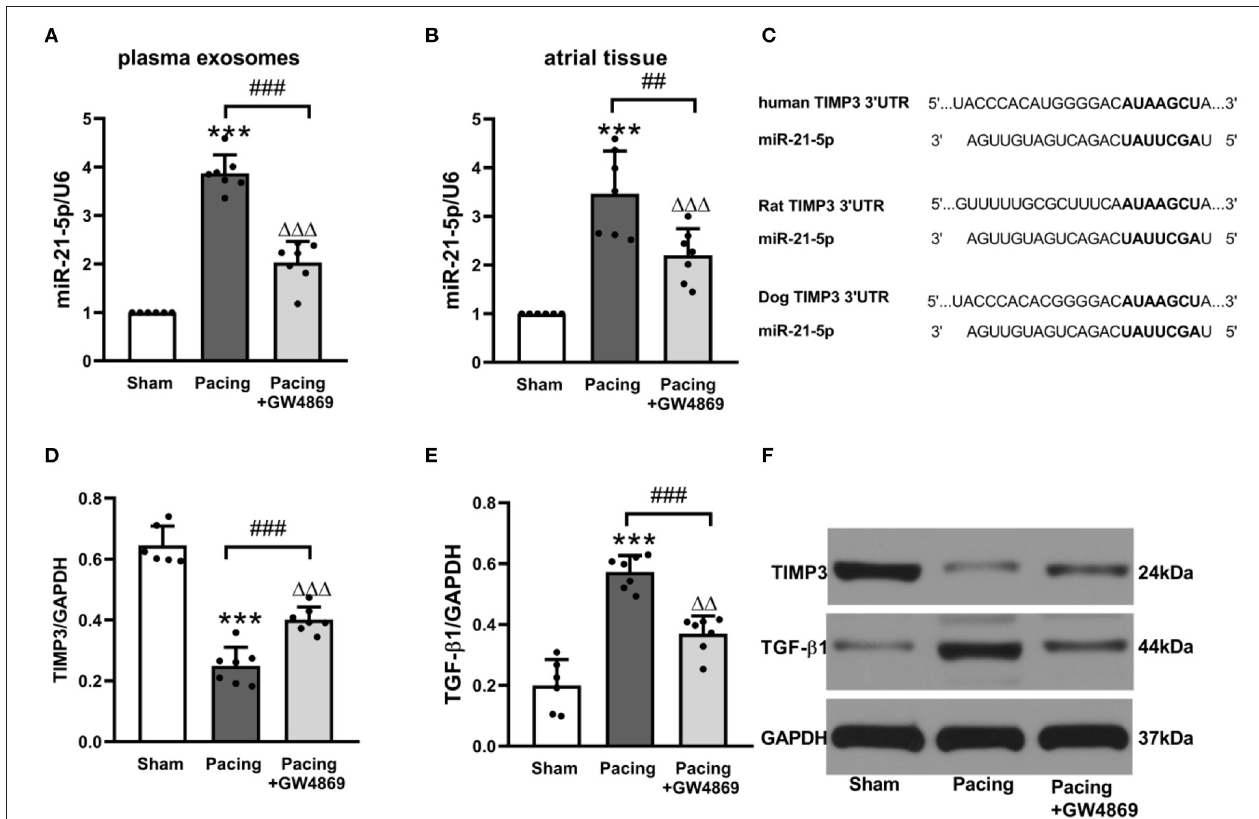
FIGURE 6 | Possible mechanism of atrial fibrosis mediated by exosomes. (A,B) Relative levels of miR-21-5p and U6 in plasma exosomes and atrial tissue ( n = 6 for the sham group and n = 7 for the pacing and GW4869 groups). (C) Predicted miR-21-5p target sequences in the 3 ′ UTR of TIMP3 among humans, rats, and dogs. (D–F) Representative Western blotting images and the mean expression levels of TIMP3 and TGF- β 1 in the atria ( n = 6 for the sham group and n = 7 for the pacing and GW4869 groups). *** P < 0.001 vs. the sham group. ## P < 0.01, ### P < 0.001 vs. the pacing group. 11 P < 0.01, 111 P < 0.001 vs. the sham group. miR-21-5p, microRNA-21-5p; TIMP3, tissue inhibitor of metalloproteinase 3; TGF- β 1, transforming growth factor- β 1; AF, atrial